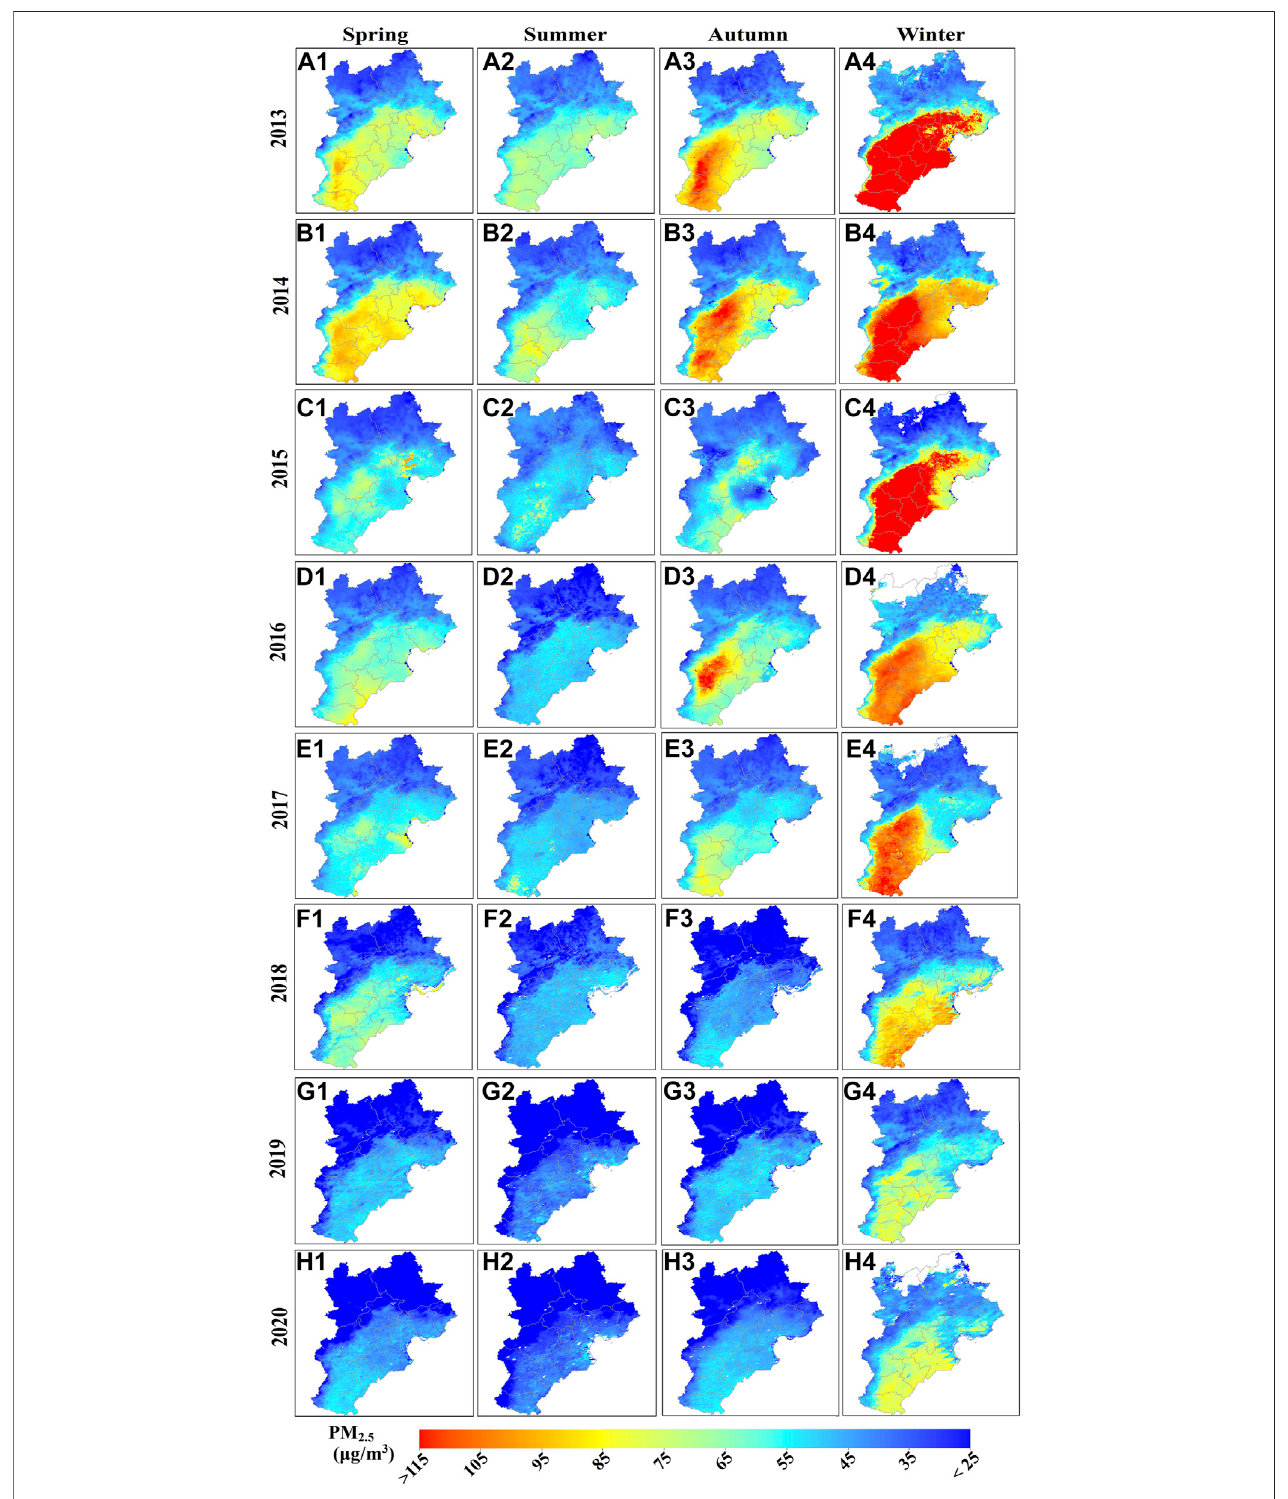
FIGURE 7 | Distribution of mean PM 2.5 concentrations in spring (A1 – H1) , summer (A2 – H2) , autumn (A3 – H3) , and winter (A4 – H4) in the Beijing – Tianjin – Hebei region during 2013 – 2020.